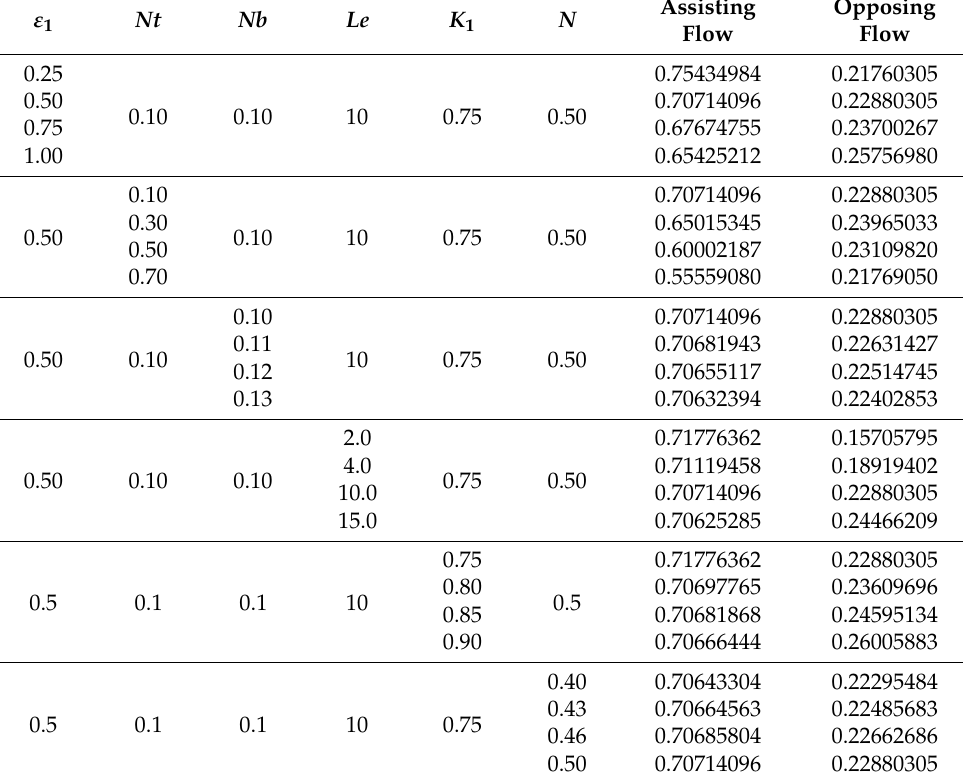
Table 3. Numerical values of heat transfer Nu x for several values of influential